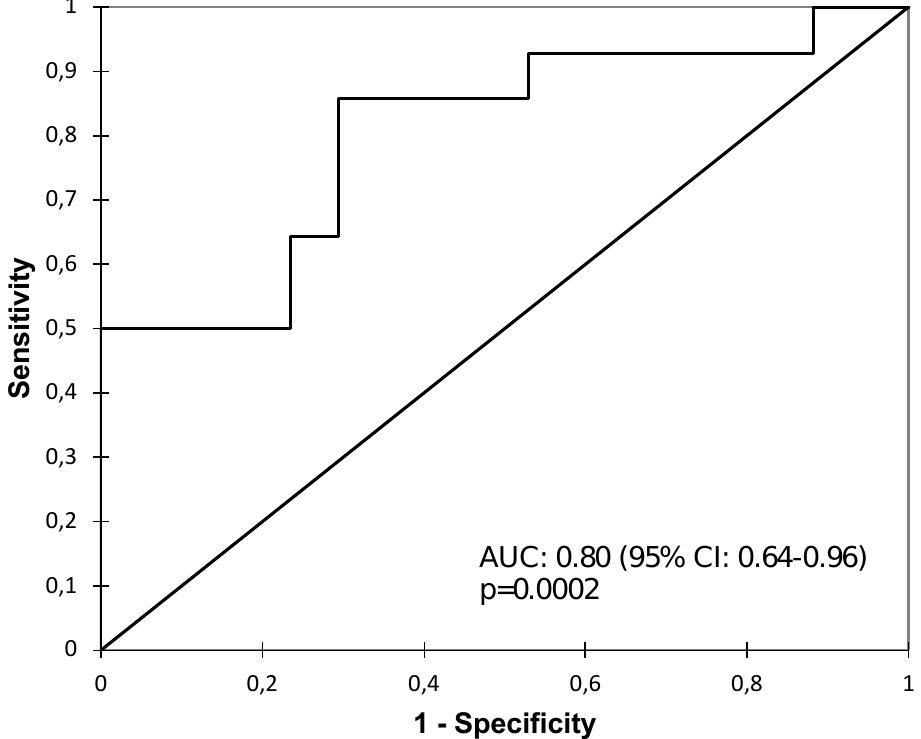
Figure 3. The ROC curve analysis of miR-21to discriminate between the IFTA 0 + I and IFTA II + III groups.